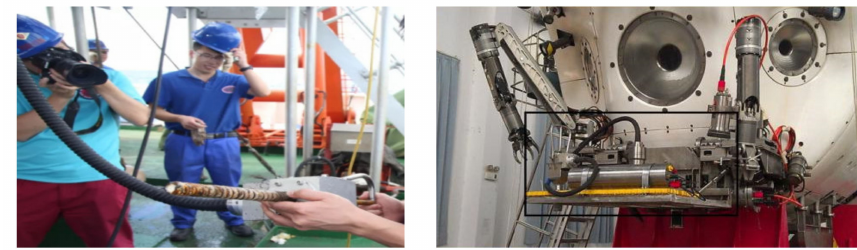
Figure 14. The drilling apparatus on the Jiaolong submersible.